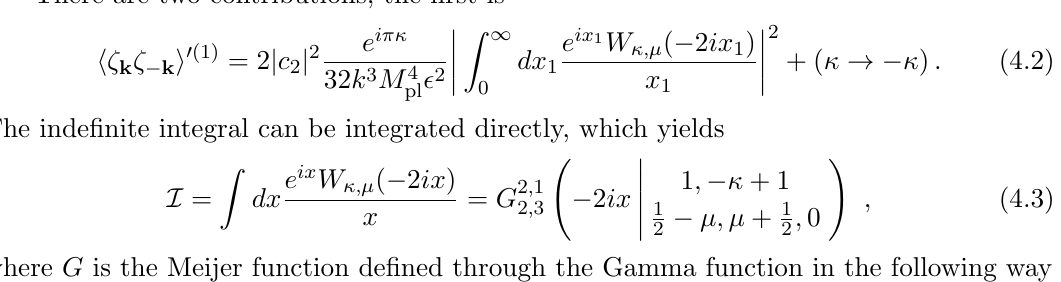
Figure 2 . The comoving velocity of the particle with respect to the physical time t . We take the Hubble parameter to be 1 in making the plot. We choose the initial time to be t and t = 30 to ensure 60 e-folds. We here plot the evolution of the velocity in the subhorizon f level. Initially, the velocity of the particle is zero. Through the acceleration from the electric (cid:12)eld, the velocity of the particle increases and the direction depends on the charge of the particle. For stronger electric (cid:12)elds,the maximum velocity attained is much larger. After some time, the particle starts to decelerate and its velocity slowly decreases to zero due to the Hubble expansion of the universe. We can see the velocity has decreased to zero at subhorizon level. Hence, the change in the frequency of the oscillatory signal in the bispectrum can’t be observed as the bispectrum is imprinted at late